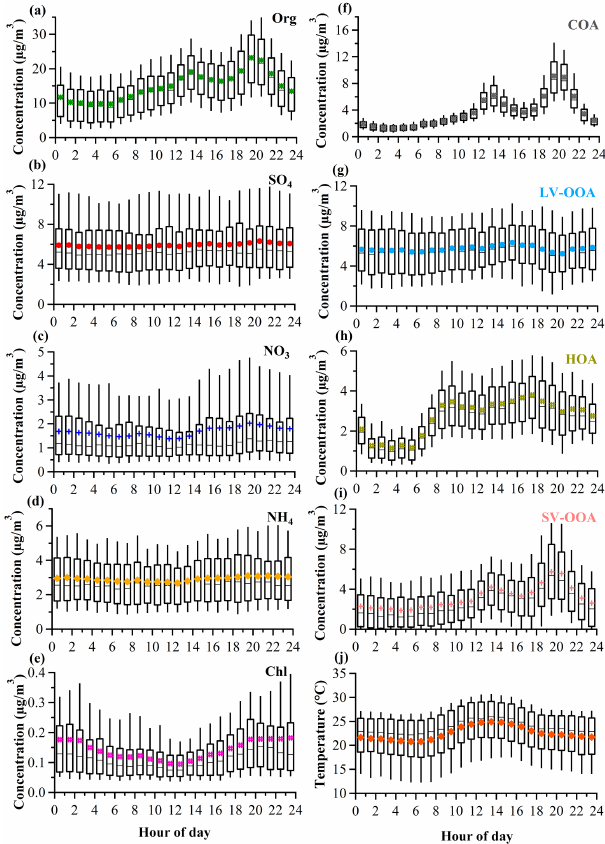
Figure 4. Diurnal profiles of NR-PM 1 species, OA components and temperature for the entire study with 25th and 75th percentile boxes, 10th and 90th percentile whiskers, mean as colored marker and me- dian as black line in the whisker box.